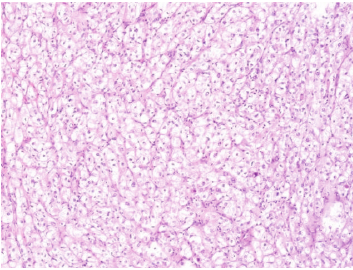
Figure 5: Focal alveolar pattern. These areas are suggestive of an alveolar soft part sarcoma.